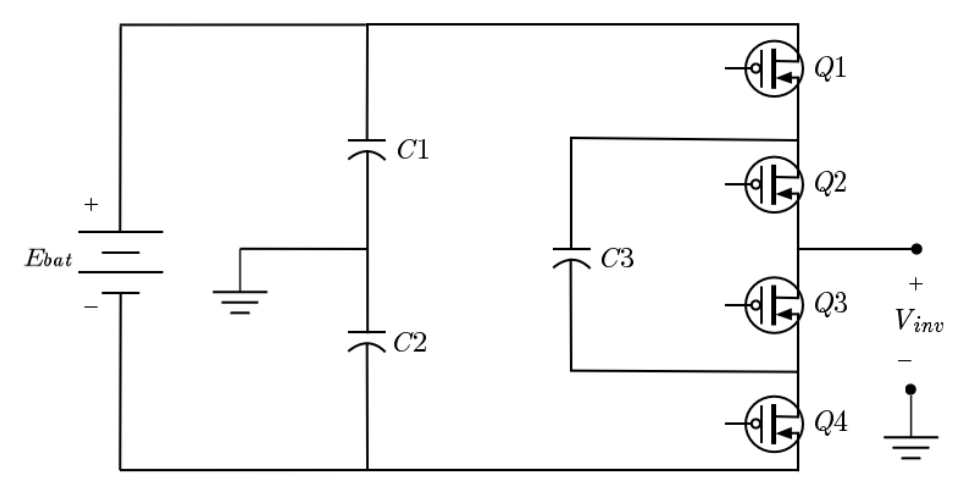
Figure 2. The three-level capacitor clamped inverter utilized in this work.